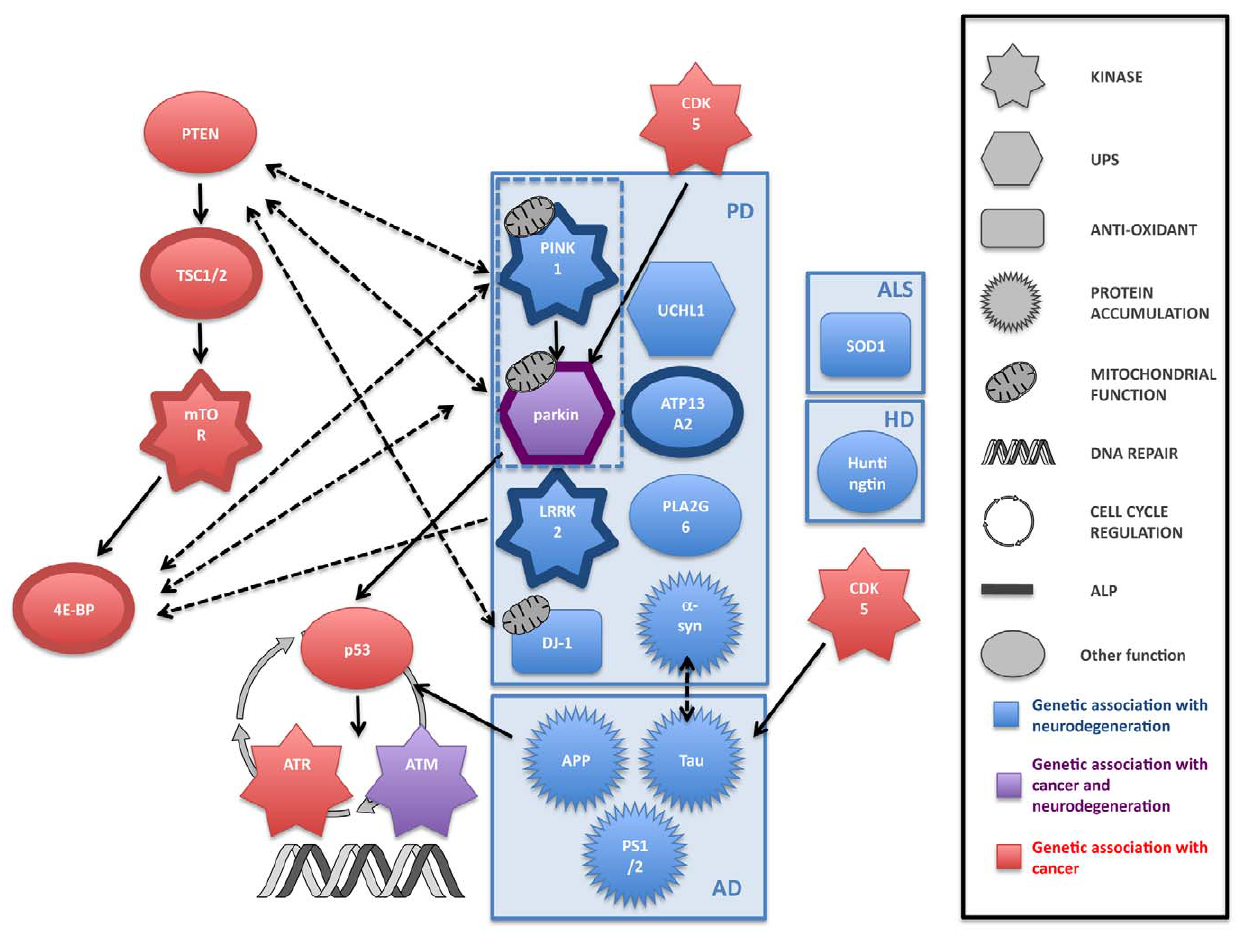
Figure 1. Common pathways to cancer and neurodegeneration? An illustration of some of the genes that are linked to cancer and neurodegeneration, and the crosstalk plus overlap between them. Although the links between genes involved in the individual disorders themselves are not yet completely clear (for example, there is evidence that there may be several parallel pathways leading to cell loss in the substantia nigra and the clinical symptom of parkinsonism), there is an intriguing picture emerging of fundamental links between cell proliferation and cell death. ALP, autophagy-lysosome pathway; UPS: ubiquitin-proteasome system.